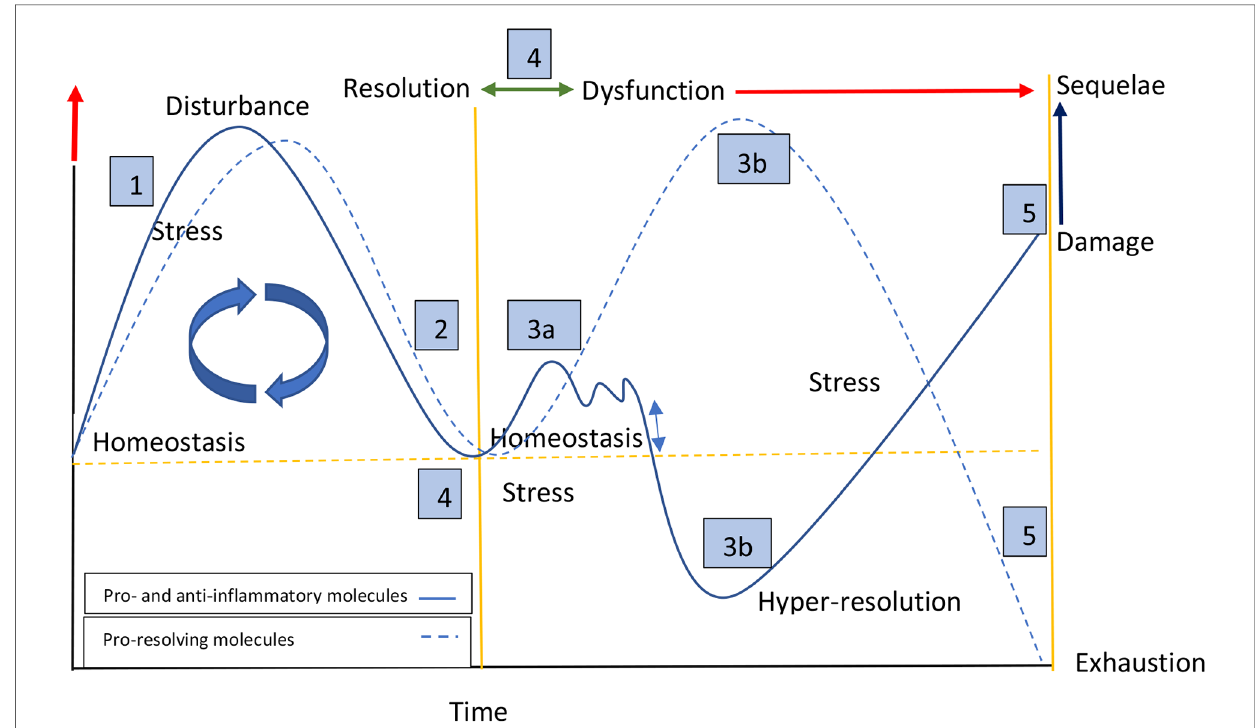
FIGURE 5 Dynamic model of the in fl ammatory response: persistent systemic stress and hyper-resolution. Left panel : a typical acute response starting from homeostatic parameters. Triggered by cellular stress, homeostasis is disrupted and (1) pro-in fl ammatory/anti-in fl ammatory, and (2) pro-resolving responses are subsequently activated. Right panel : persistent tissue dysfunction leads to two possible pathways: (3a) sustained, low-grade, fl uctuating, and parallel pro-in fl ammatory and anti-in fl ammatory responses, with no or low pro-resolving response; (3b) depressed pro-in fl ammatory and anti- in fl ammatory responses, in some cases accompanied by elevated concentrations of pro-resolving molecules (hyper-resolution). (4) If the dysfunction resolves, the system would return to a homeostatic state (bidirectional green arrow, and crossing of yellow lines). (5) If dysfunction continues (red arrow), a point of no return may be reached along with long-term in fl ammation, depletion of pro-resolving molecules, damage, and